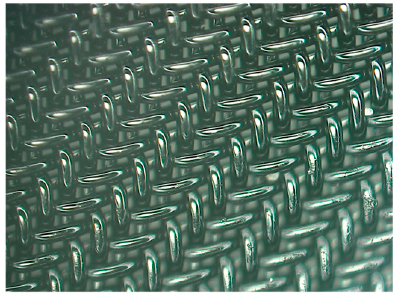
Figure 15. Screen sample.